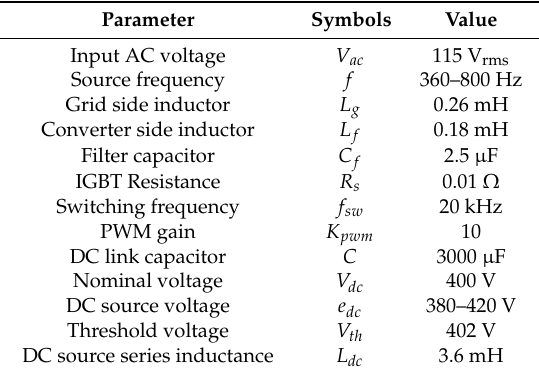
Table 2. Simulation Parameters.